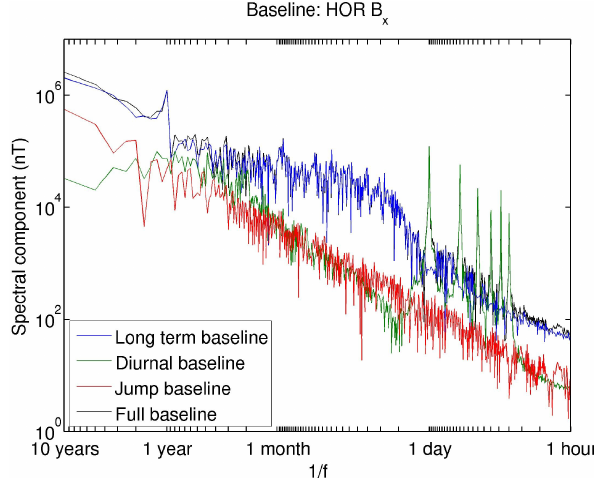
Fig. 12. Spectra of the the B x field in Hornsund (blue), the full baseline (green), and the magnetic field data after removal of the baseline (i.e. the disturbance field;